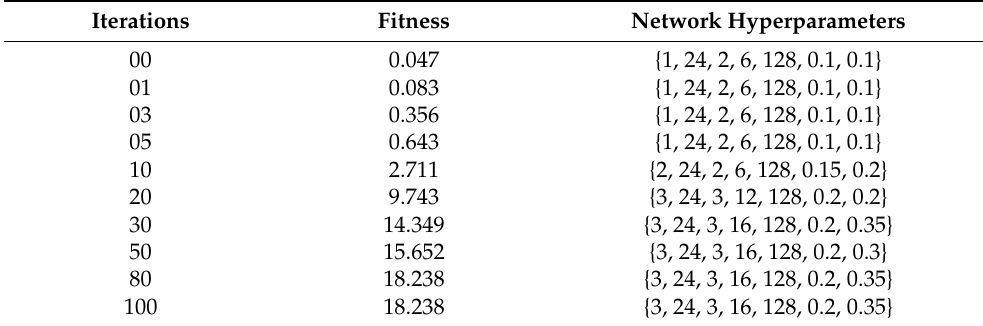
Table 13. The best fitness and corresponding network hyperparameters in dataset 3.